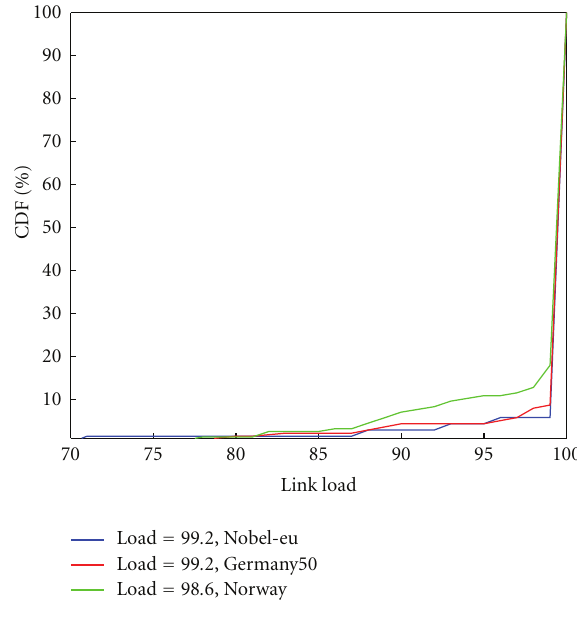
Figure 4: Average link